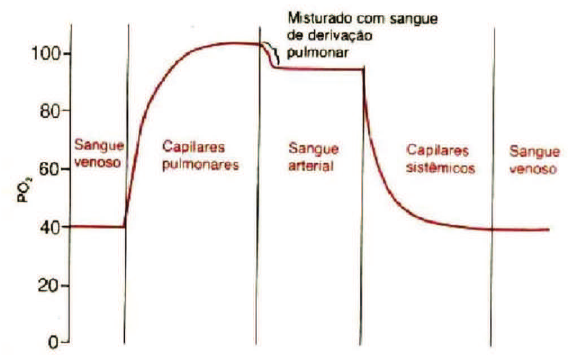
Fig. 3 - Variação da PO do sangue capilar pulmonar para o 2 sangue arterial. Essa diferença deve-se ao efeito da mistura